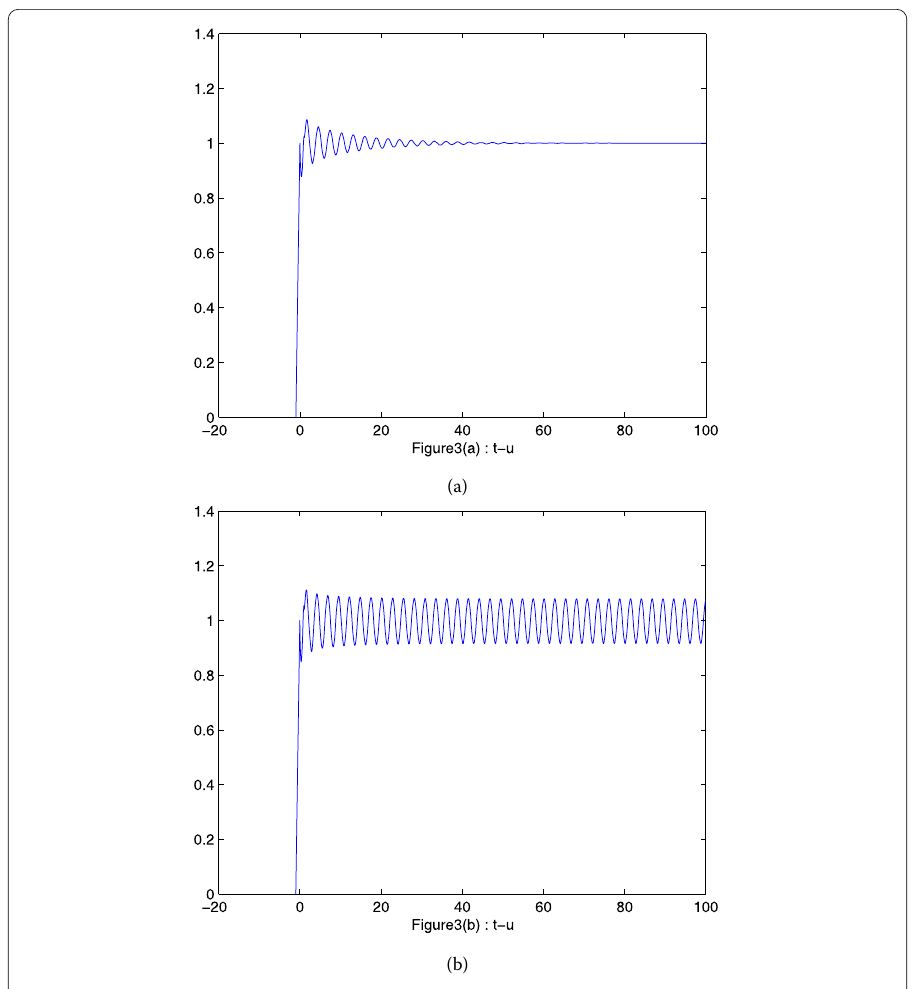
Figure 3 The numerical solution of Eq. (2.11) with PD control Euler method corresponding to k p = –0.2, k d = 0.2 when ( a ) τ = 5, ( b ) τ =